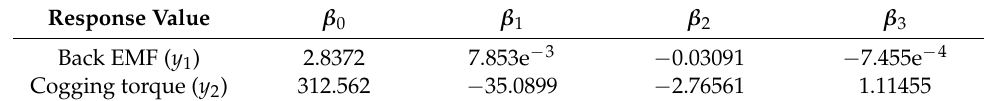
Table 5. Coefficients of the regression model.